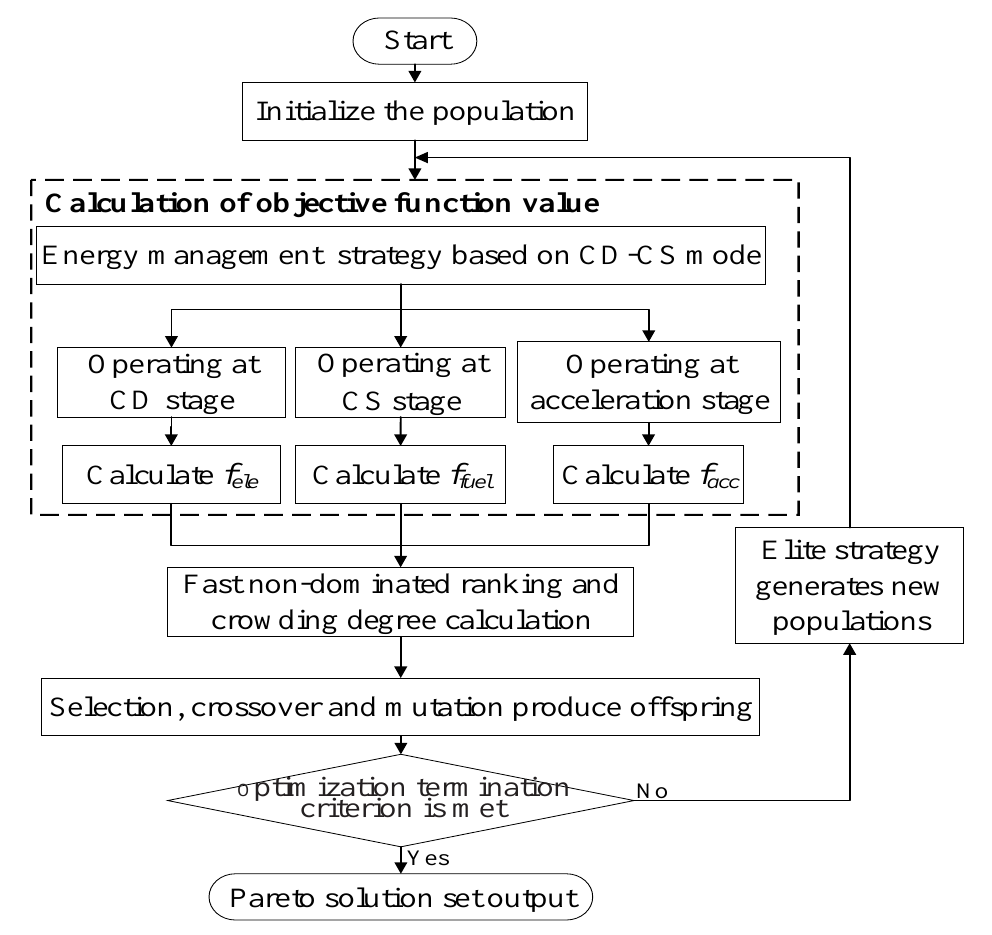
Figure 10. The flow chart of multi-objective parameter optimization based on the non-dominated sorting genetic algorithms-II (NSGA-II) algorithm.